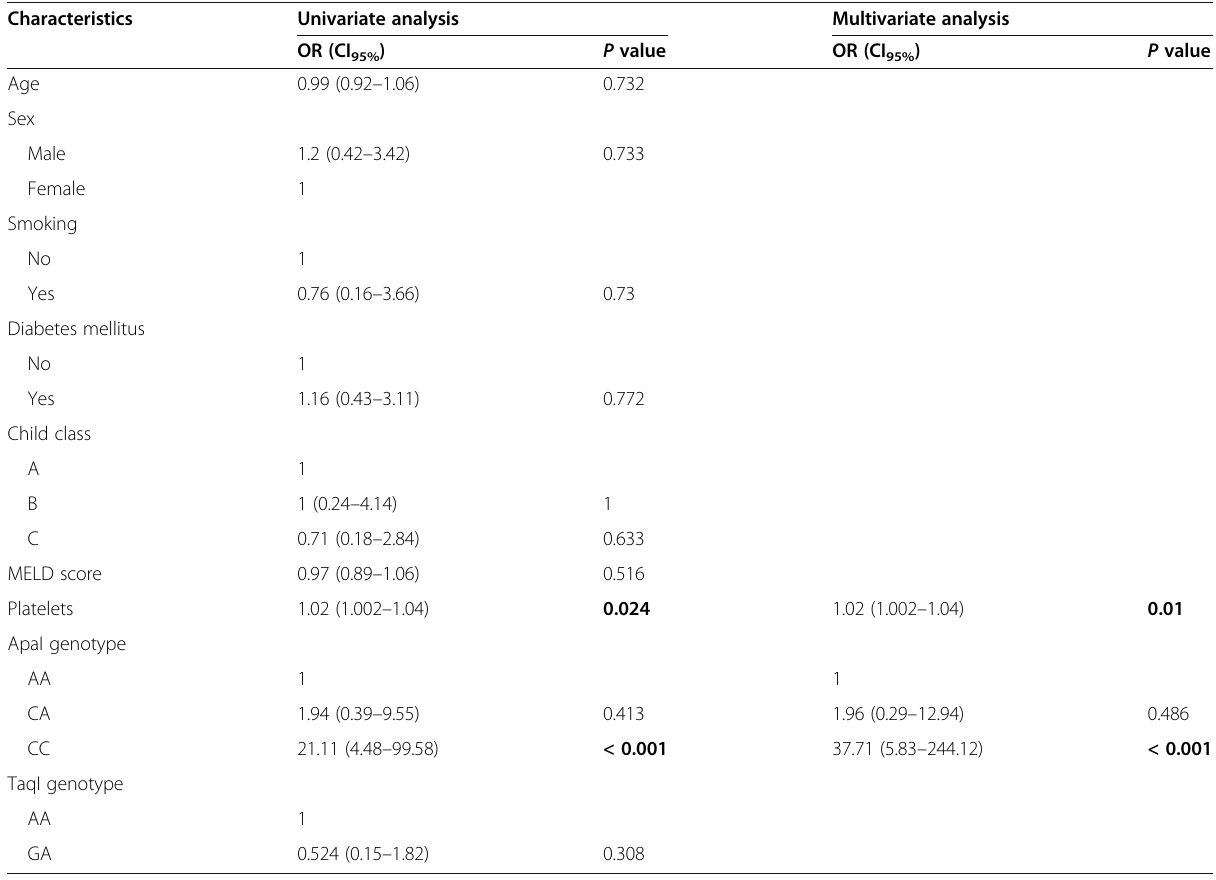
Table 5 Univariate and multivariate binary logistic regression analysis of predictor variables of HCC in patients with HCV-related liver cirrhosis